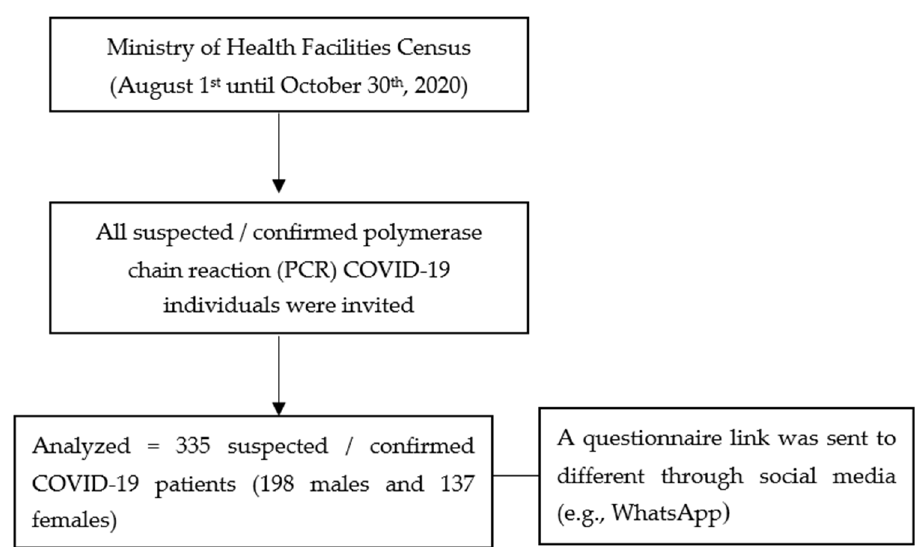
Figure 1. Flowchart of participants.